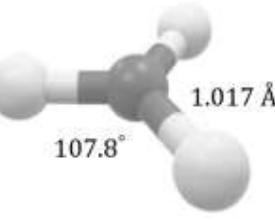
Figure 1. The geometry optimization of ammonia molecule (N ILSSON ,